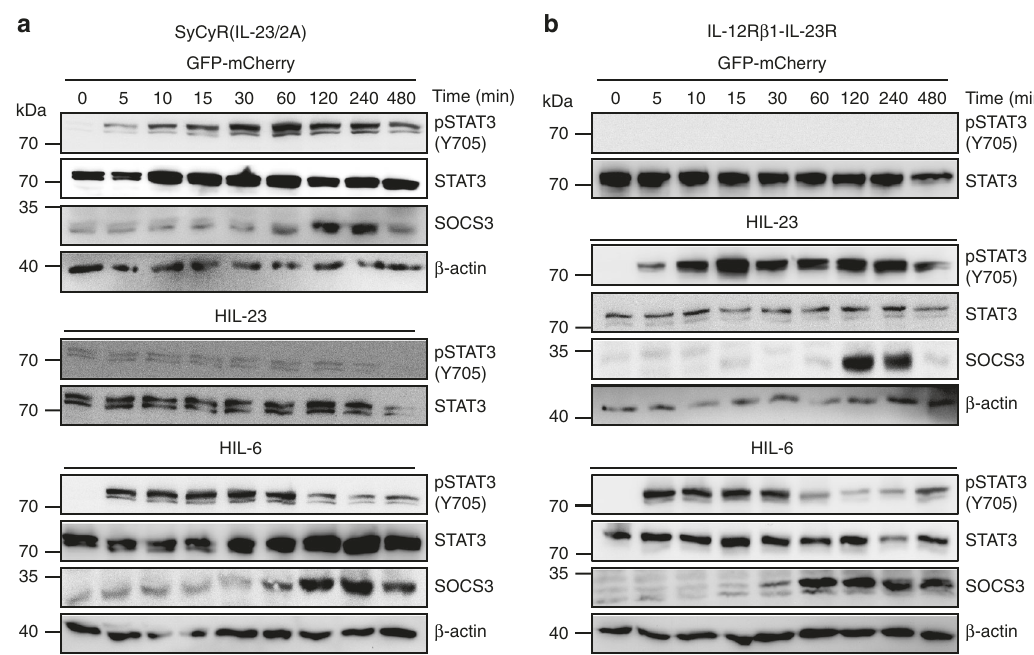
Fig. 2 Synthetic cytokine receptors for IL-23 (SyCyR(IL-23/2A)) simulate kinetics of IL-23-induced STAT3 activation and SOCS expression in transduced Ba/F3-gp130 cells. a Ba/F3-SyCyR(IL-23/2A) cells were washed three times, starved, and stimulated with GFP-mCherry (100 ng/ml), HIL-23 (25 ng/ml), and HIL-6 (25 ng/ml) for 0 – 480 min. Stimulation with HIL-23 and HIL-6 were used as control. Cellular lysates were prepared, and equal amounts of total protein (50 μ g/lane) were loaded on SDS gels, followed by immunoblotting using speci fi c antibodies for phospho-STAT3 and STAT3, SOCS3, and β -actin. Western blot data show one representative experiment out of three. b Ba/F3-IL-12R β 1-IL-23R cells were washed three times, starved, and stimulated with HIL-23 (25 ng/ml) for 0 – 480 min. Stimulation with GFP-mCherry (100 ng/ml) and HIL-6 (25 ng/ml) were used as control. Cellular lysates were prepared, and equal amounts of total protein (50 μ g/lane) were loaded on SDS gels, followed by immunoblotting using speci fi c antibodies for phospho-STAT3 and STAT3, SOCS3, and β -actin. Western blot data show one representative experiment out of